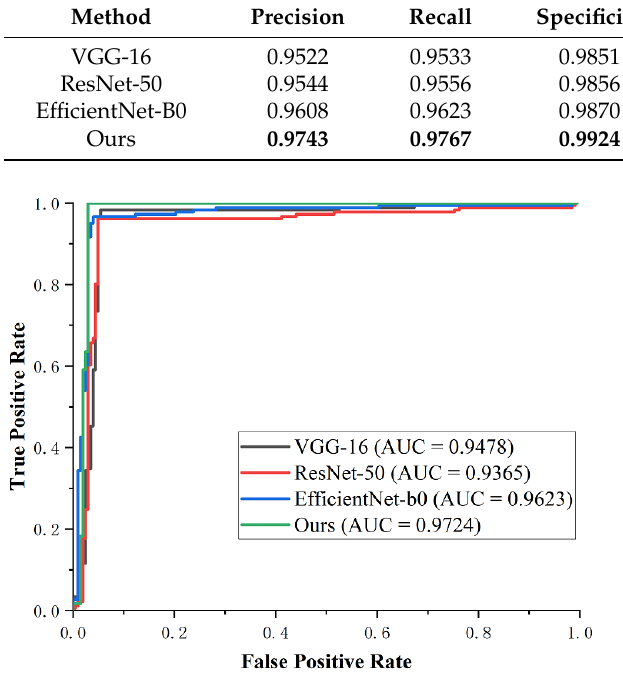
Figure 11. Comparison of the ROC curves of different